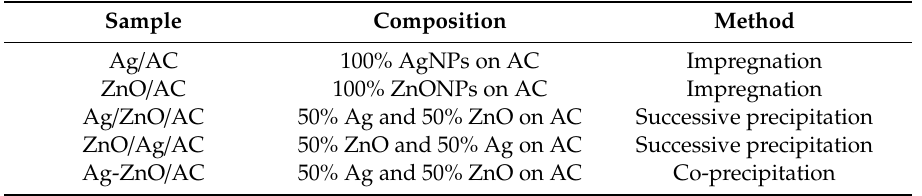
Table 4. Sample description and preparation